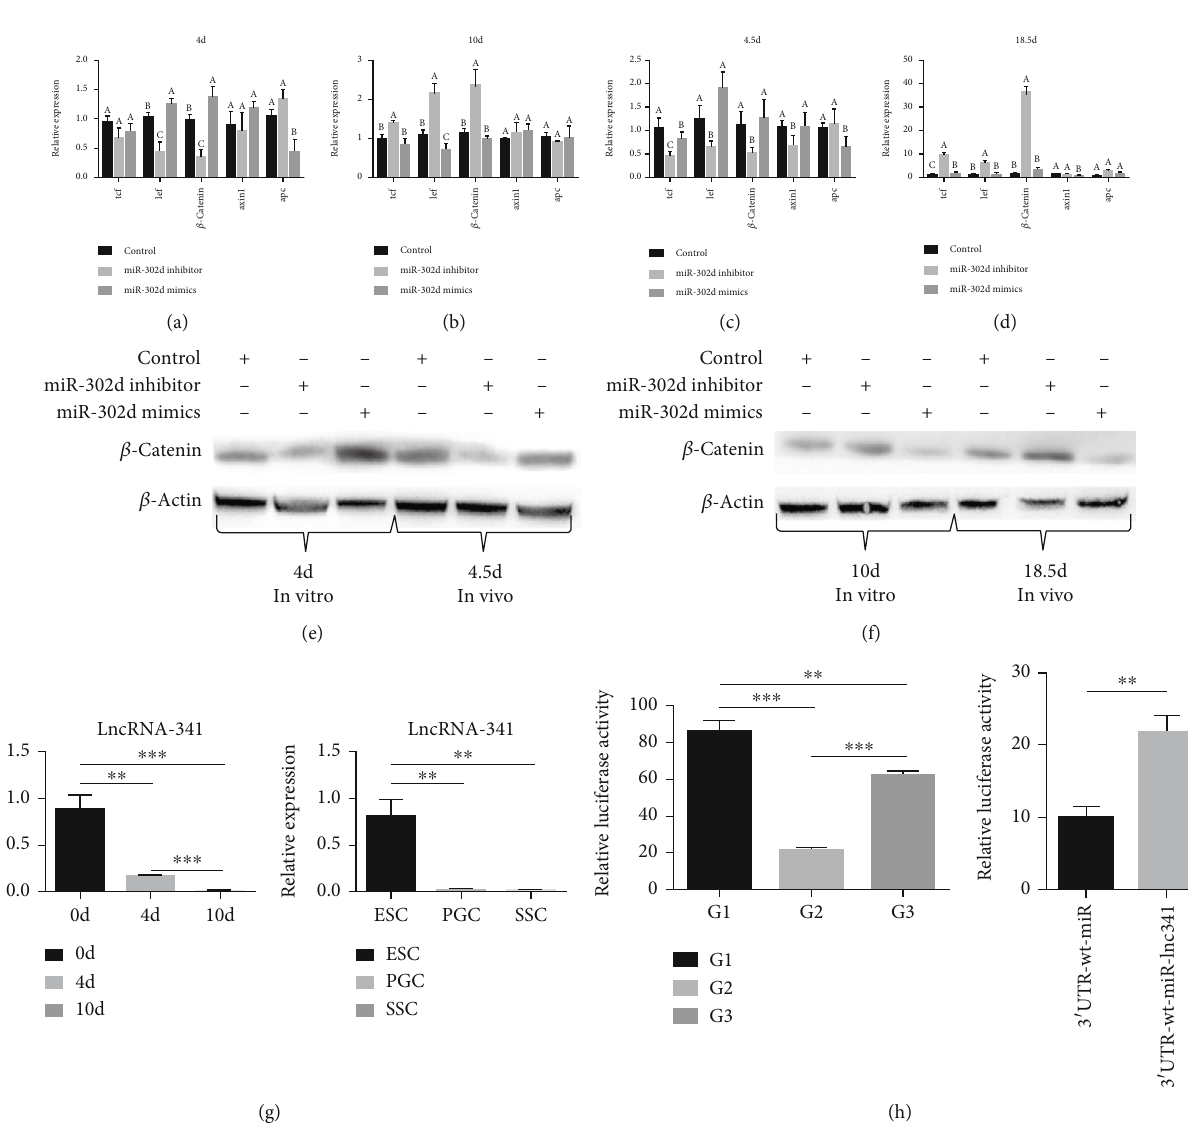
Figure 9: Wnt signaling pathway veri fi cation and ceRNA veri fi cation. (a) qRT-PCR result of related genes in Wnt signaling pathway of day 4 in vitro. (b) qRT-PCR result of day 10 in vitro. (c) qRT-PCR result of day 4.5 in vivo. (d) qRT-PCR result of day 18.5 in vivo. (e) Western blot test in vitro. (f) Western blot test in vivo. (g) lncRNA-341 expression test. (h) Dual-luciferase reporting assay; G1: pmiR-tle4-wt wild type; G2: pmiR-tle4-wt+miR-302d mimics; G3:pmiR-tle4-mt+miR-302d mimics; 3 ′ UTR-wt-miR: pmiR-report-wt+pRL-TK+miRNA-302d mimics; 3 ′ UTR-wt-miR-lnc341: pmiR-report-wt+pRL-TK+miRNA-302d